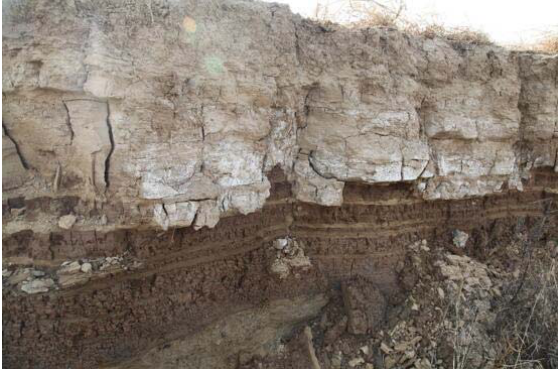
Figure 1. Typical layered structure in the lower Yellow River.